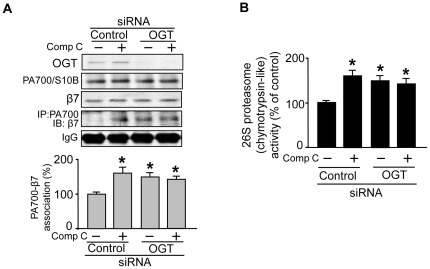
Loss of OGT increases 26S proteasome assembly.HUVEC transfected with OGT siRNA but not control siRNA show an increase in (A) association of PA700/S10B (from 19S complex) with β7 (from 20S complex) and (B) 26S proteasome activity, mimicking the effect of AMPK-suppression by compound C (10 µmol/L for 2 hour). The blots shown are representative of 3 independent experiments. * represents p<0.05 vs the control (without compound C treatment).